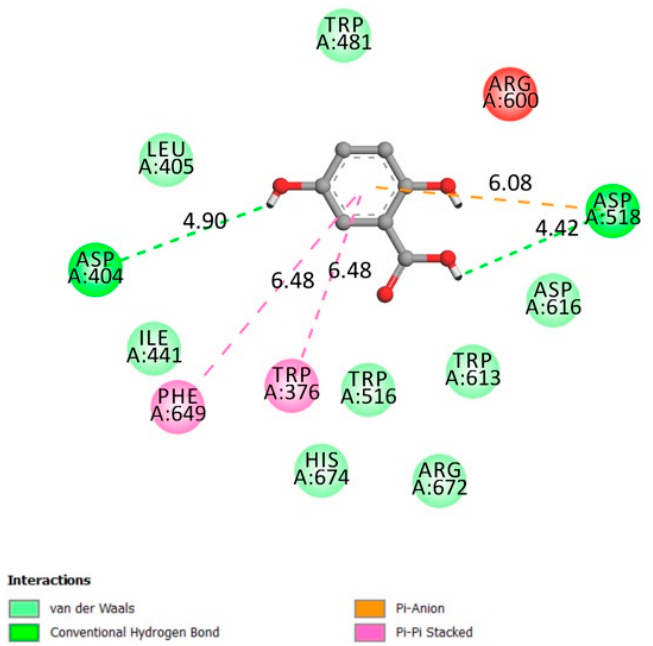
Figure 4. Two-dimensional scheme of the GA interactions with α -glucosidase receptor.